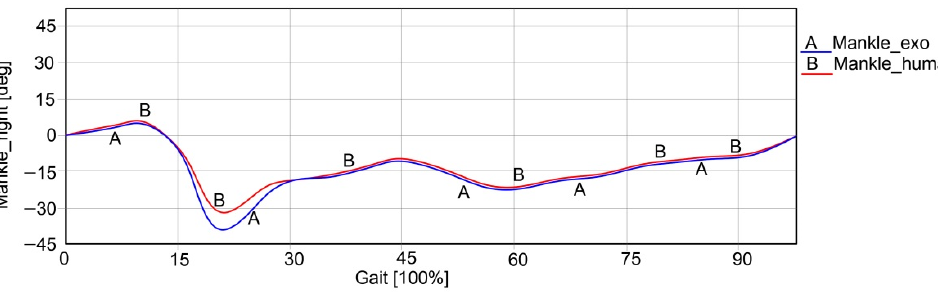
Figure 35. Right ankle angular variation exoskeleton vs. human subject during a complete gait.